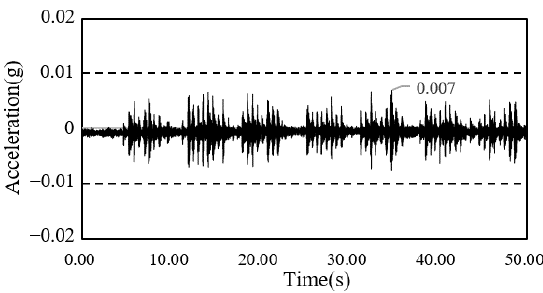
Figure 17. Time history of acceleration after cladding completion (Sangsoo-dong building).